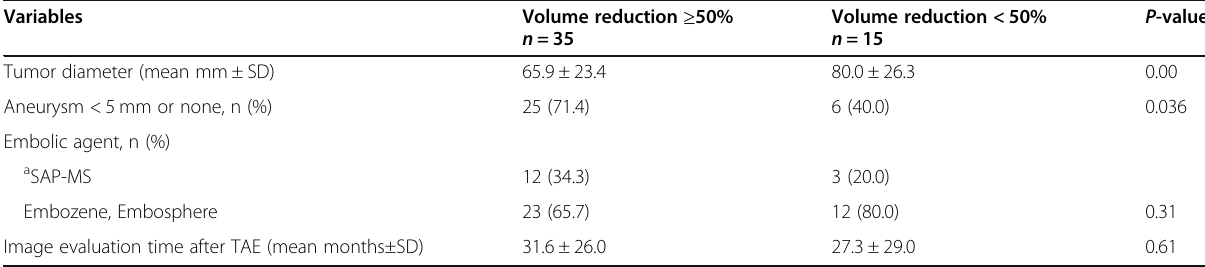
Table 2 AMLs ’ characteristics